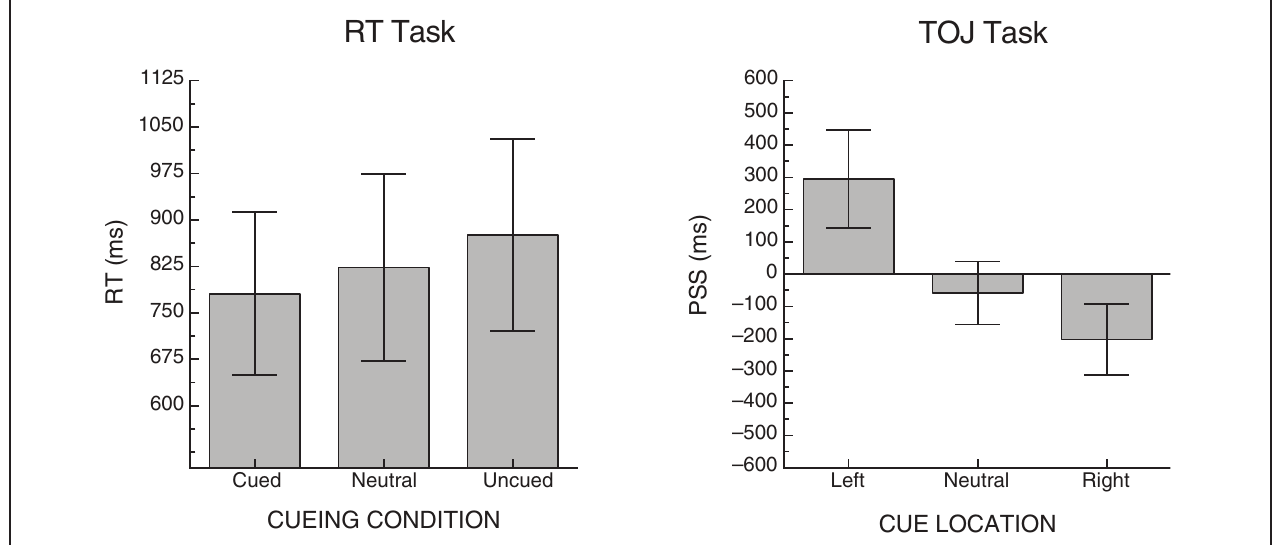
FIGURE 2 | Mean cueing effects for each of the two tasks across all participants. Error bars represent + / − the standard error of the mean for each